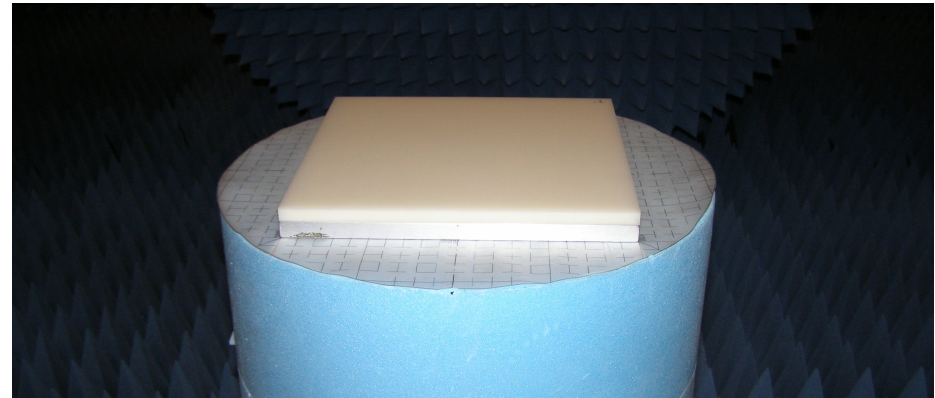
Figure 2. Metal-backed sample of